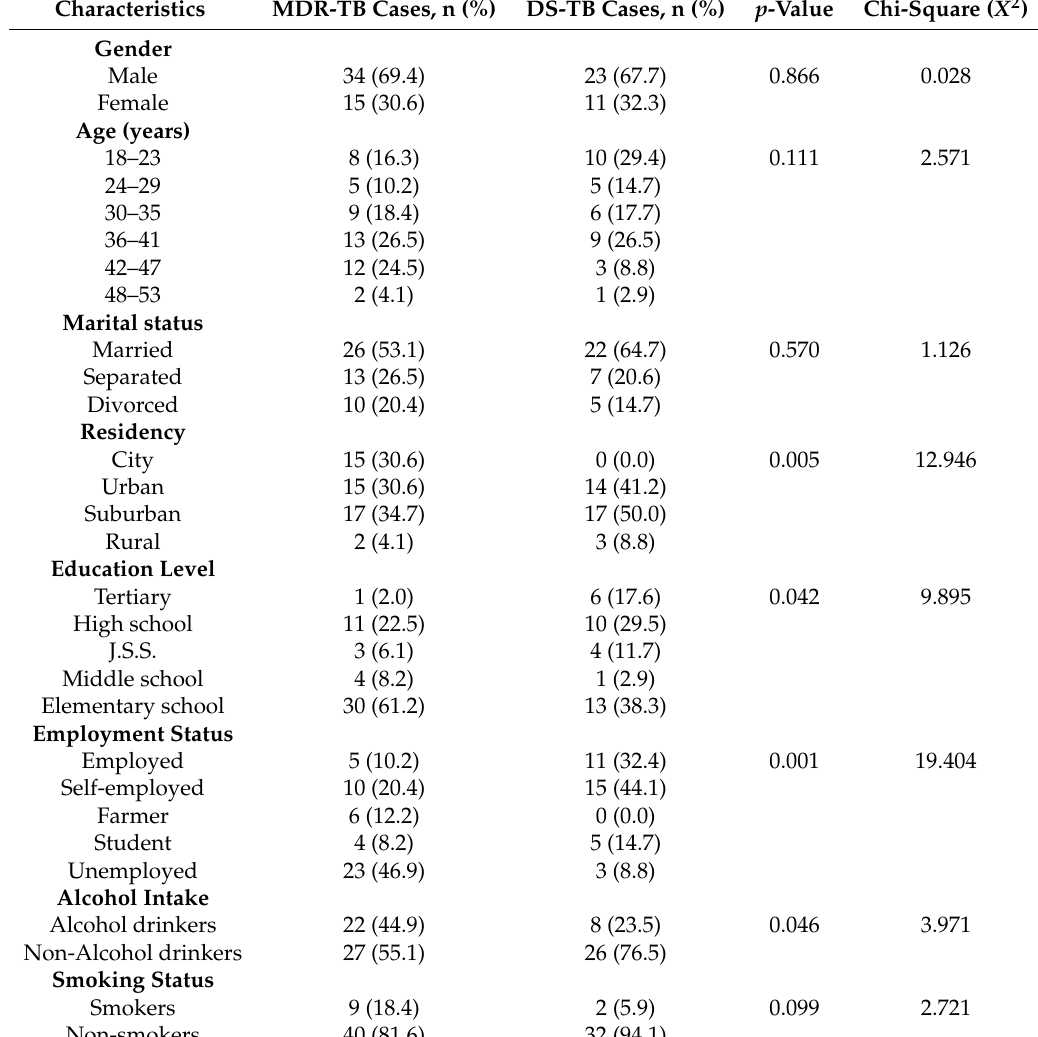
Table 1. Socio-economic and risk factor information of the study participants (N =